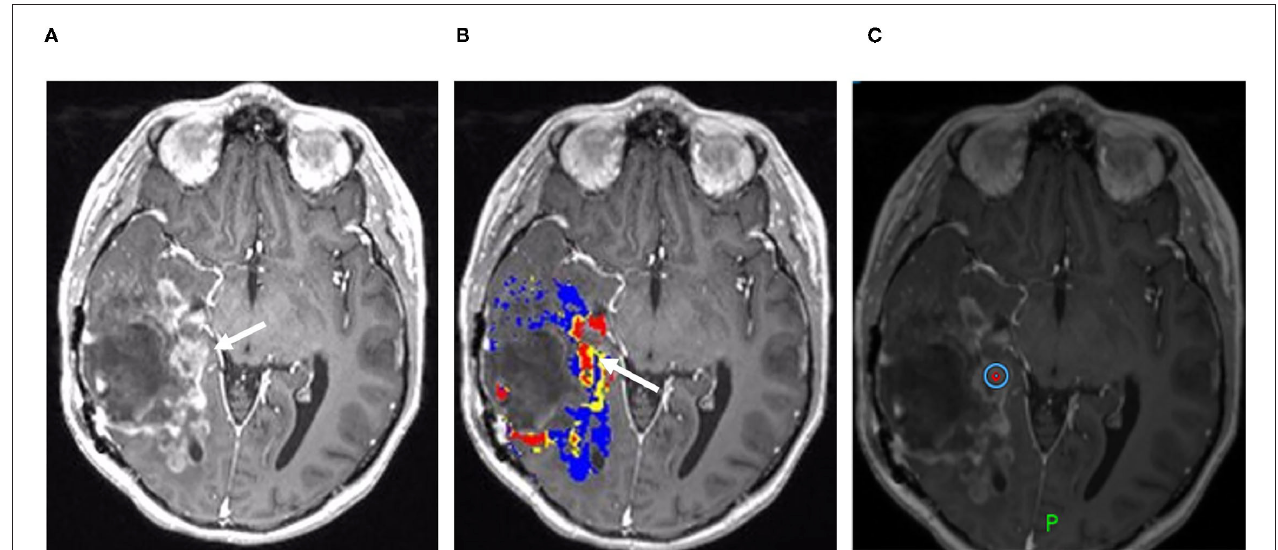
FIGURE 3 | Recurrent tumor on DSC-MRI: A 27-year-old man with right temporoparietal GBM with prior surgical resection with carmustine wafer placement and adjuvant radiation/temozolomide. Five months after surgical resection, the patient experienced clinical deterioration with signs of increased intracranial pressure with clinical concern for tumor progression vs. pseudoprogression. His symptoms did improve with steroid therapy. (A) Axial postcontrast T1 weighted image shows a large area of nodular and ring-like enhancement along the medial margin of the resection cavity (arrow). (B) The DSC FTB map derived from rCBV thresholds demonstrates high FTB centrally in the area of nodular enhancement consistent with the tumor. (C) The patient underwent surgical debulking, and the stereotactic biopsy at the site of the elevated rCBV (circular marker) was positive for 80% recurrent viable tumor.